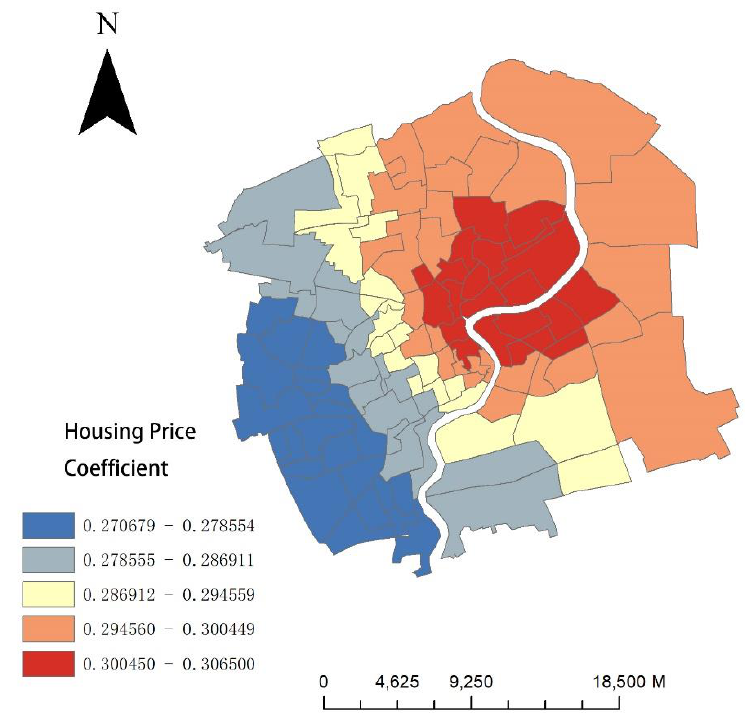
Figure 13. Housing-price coefficients at each county or jiedao.